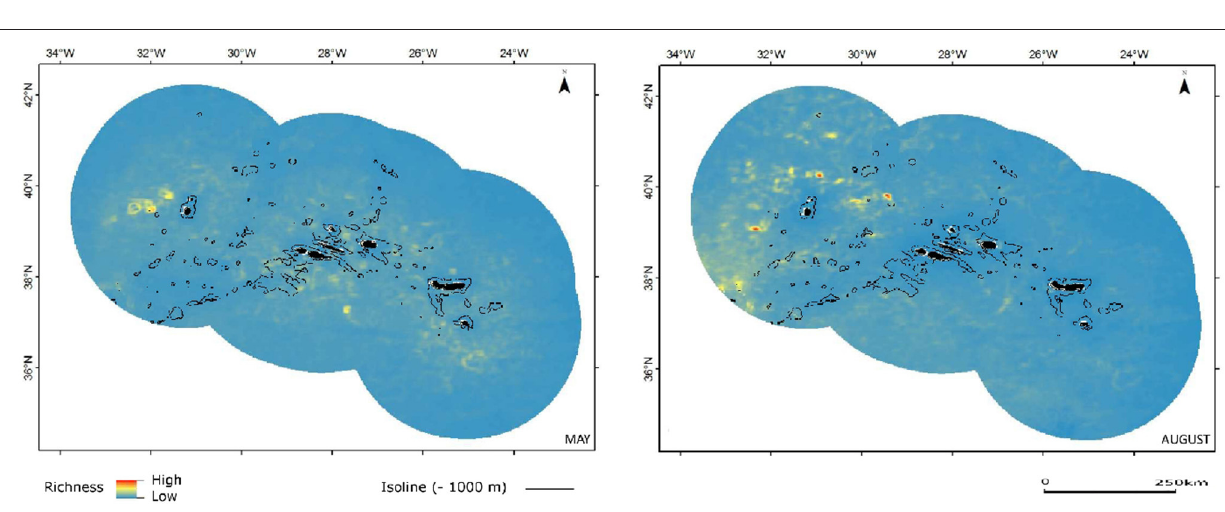
FIGURE 7 | Combined predicted richness of sperm and beaked whales in spring (May) and summer (August). Color scheme as in Figure 3